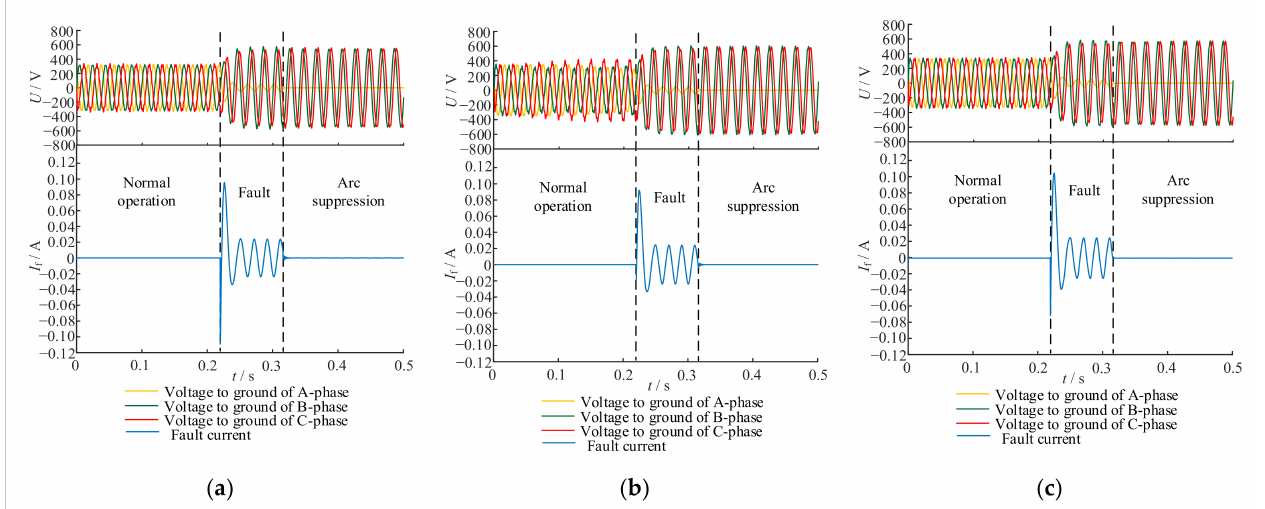
Figure 8. Experimental results of arc suppression. ( a ) No-load condition; ( b ) 50% load condition; ( c ) 100% load condition.